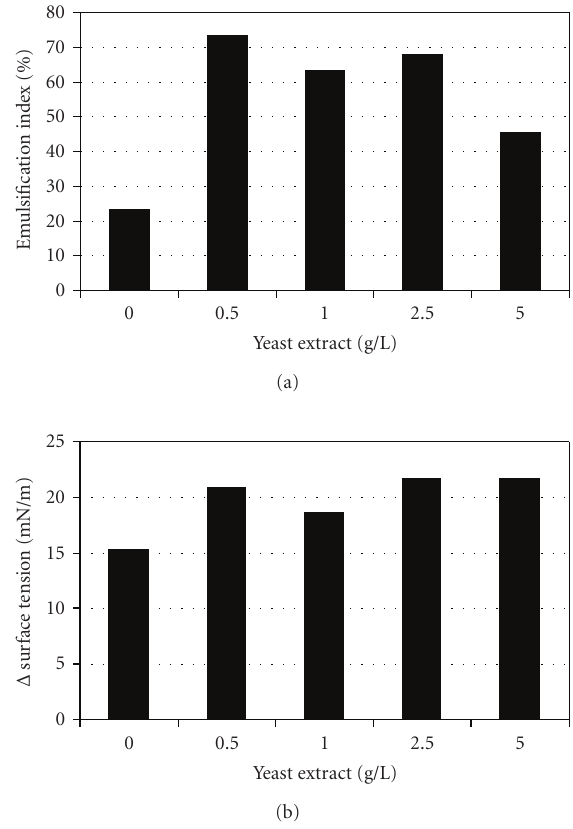
Figure 3: Biosurfactant production by Yarrowia lipolytica with di ff erent YE concentration. (a) Emulsification index and (b) maximum variation of surface